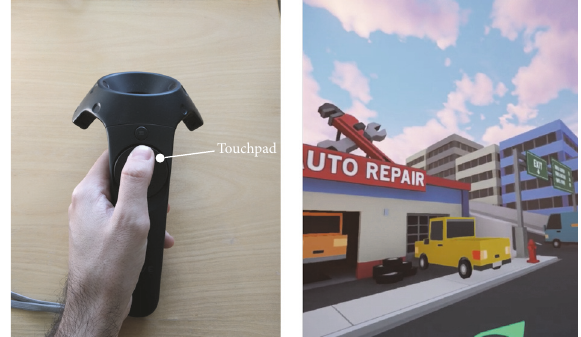
Figure 2: A user testing the walking-in-place (WIP) tech- nique. Video demonstration of virtual navigation: http://boletsis .net/vrloco/wip/.